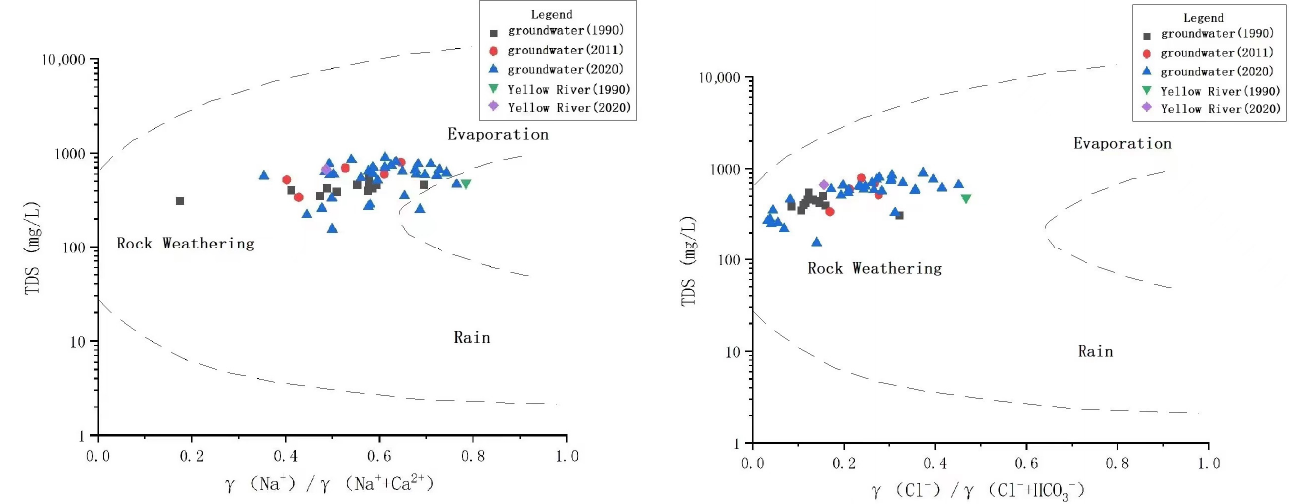
Figure 12. Gibbs map of groundwater in the study area.